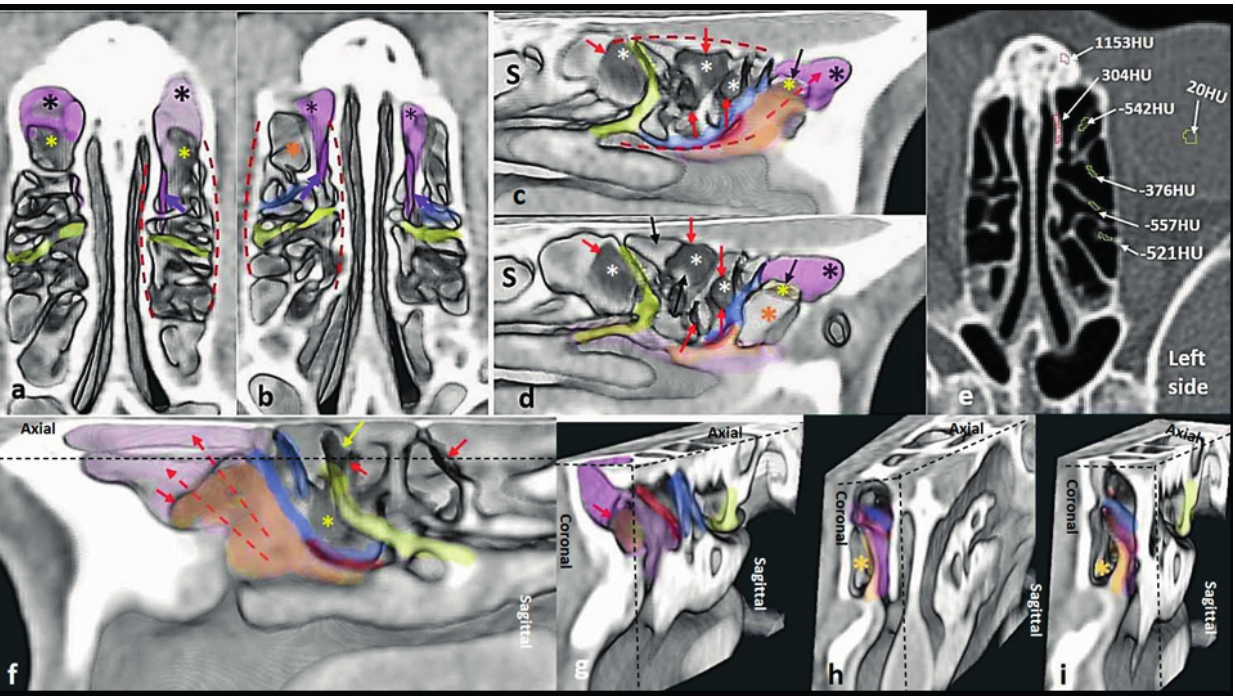
Figure 3. The “rebuilding” of the AES and PES, and the expansion of the FS by the MM in a three years-ten months old patient. a.-d. 3D axial images (a. superior to b.), and (c., d.) left side 3D sagittal images from medial to lateral reveal the extension and communication of the MM (purple outline and arrows) with and into the FS (black asterisk). On the sagittal images, note the beginning anterior expansion of the EUP (gold) into the FS (purple), and the early expansion of the MM into the FS (red dashed arrow). The bony/cartilaginous architecture within the AES and the PES have an irregular arrangement, without defined spatial structures (within the red curved dashed outlines on fig. c.). Within the “irregularly spaced” ES lamellae, a well-defined dark membranous structure (white asterisks) expands within the borders of well-defined dark “wedgelike” borders within the outline of the LP (red arrows) expanding towards existent lamellae. These changes represent the “rebuilding” process of previously “broken up” spaces and the recreation of the final expanded spaces of the anterior and posterior ethmoid sinuses (yellow asterisks). The continued presence of the well-defined dark “rims” (red arrows) surround the origin of the membranous expansion. Bulla lamella (blue outline); basal lamella ( green outline); sphenoid sinus (S).